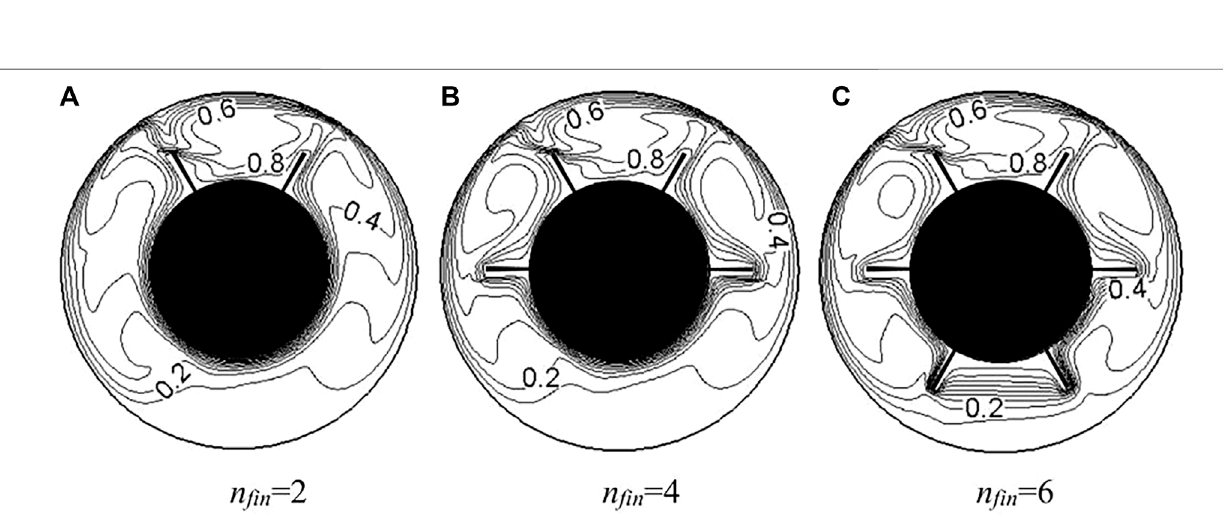
Frontiers in Energy Research |